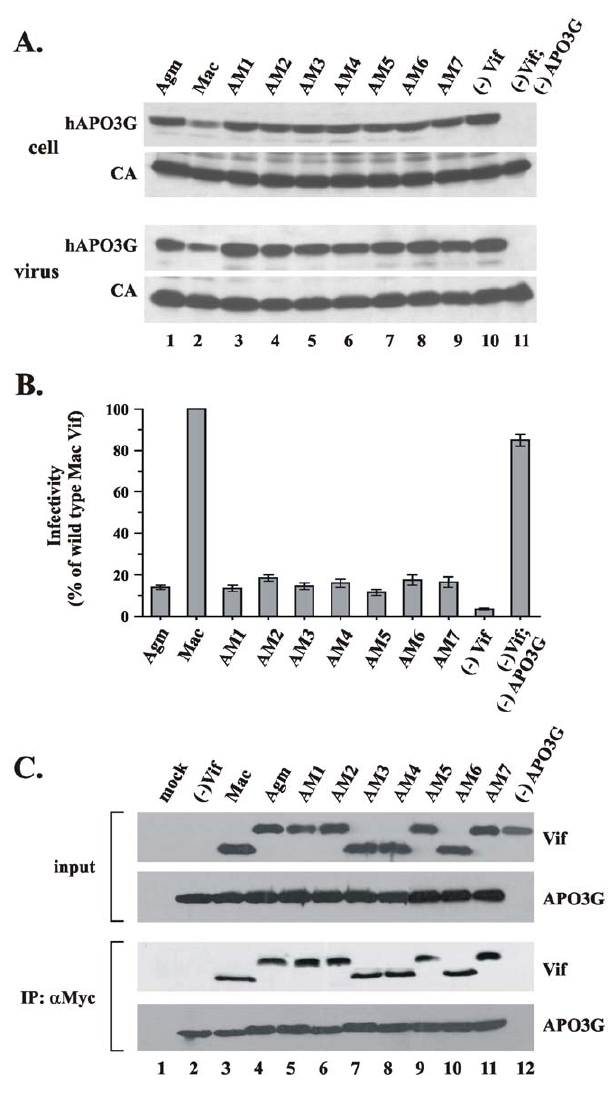
Figure 3. SIVmac/agm Vif chimeras are inactive against human APO3G. ( A ) HeLa cells were transfected to express constant amounts of Vif-defective SIVmac Vif(-) and human APO3G along with SIVagm Vif (lane 1), SIVmac Vif (lane 2), or the SIVmac/agm chimeras AM1–AM7 (lanes 3–9). Vif-negative (lane 10) or APO3G-negative samples (lane 11) were included as controls. Total amount of DNA in all samples